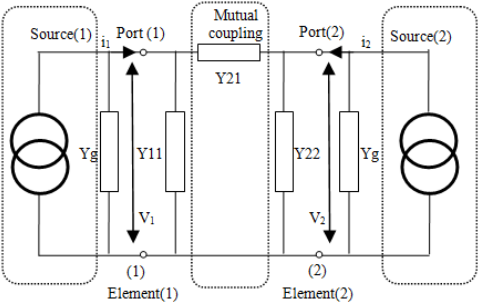
FIGURE 4. Y -network for two identical array